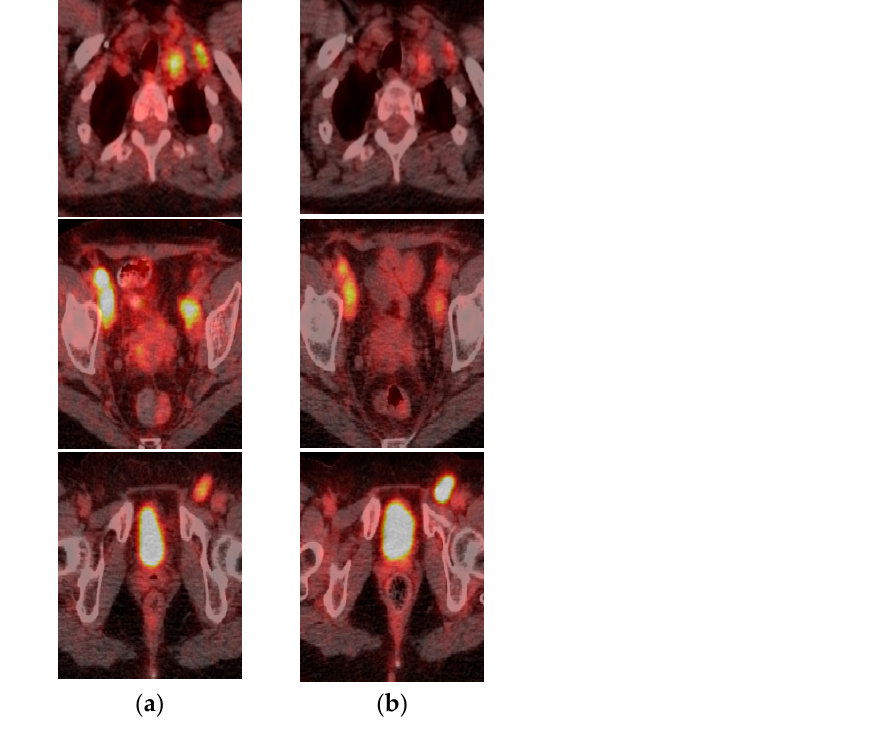
Figure 2. FDG-PET after 4 weeks of treatment with dabrafenib and trametinib showed decreased FDG avidity. ( a ) FDG-PET performed in January; ( b ) FDG-PET performed in February